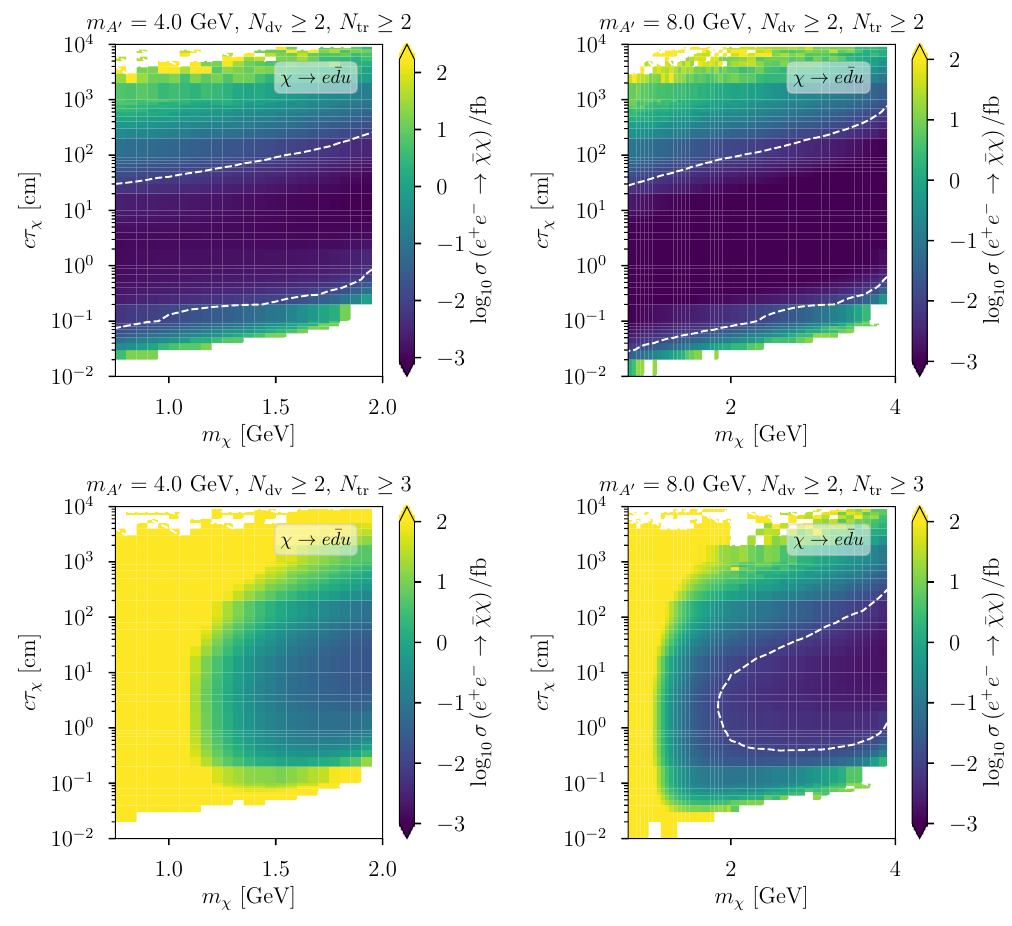
Figure 6 . Cross-section sensitivity in fb of Belle II based on 10 signal events in a 50 ab − 1 dataset for LLPs χ decaying to e + hadrons and the dark photon production mode. The upper (lower) row shows the result of demanding at least 2 (3) charged tracks from two displaced vertices. The left (right) column fixes m = 4 ( 8 ) GeV. The white dashed contours correspond to a production A 0 cross section of 10 − 2 fb , which is roughly equivalent to ε ∼ 10 − 5 for m 8 GeV A 0 ≤